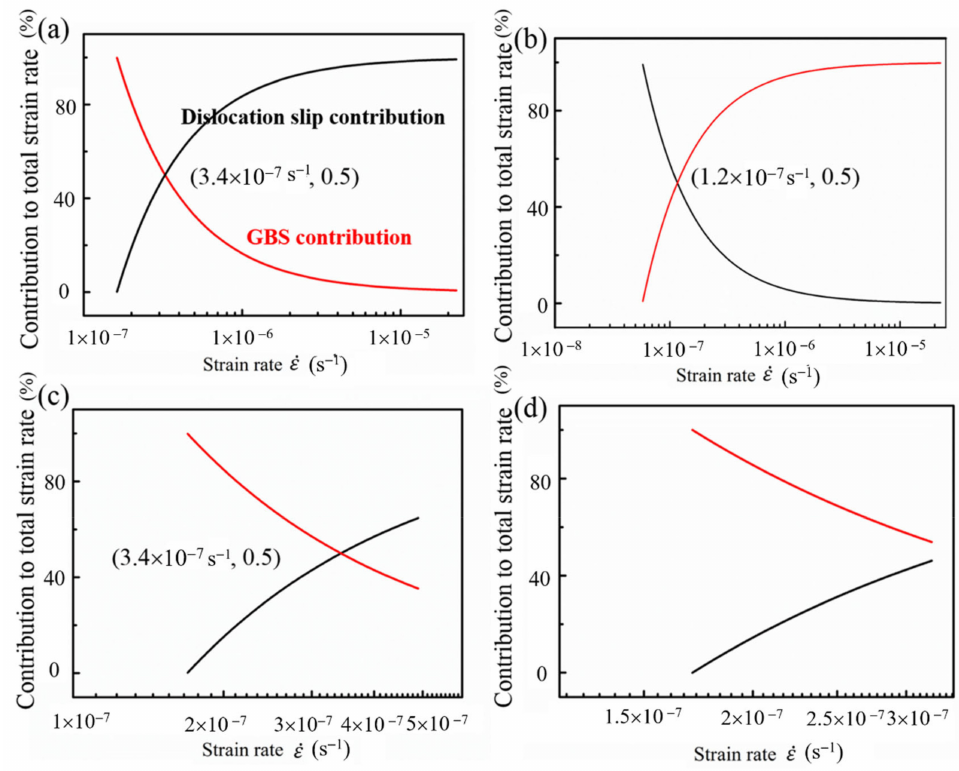
Figure 9. Normalized contribution of dislocation slip mechanism and GBS mechanism to the total strain rate in the stress relaxation test: ( a ) the first cycle; ( b ) the second cycle; ( c ) the third cycle; ( d ) the fourth